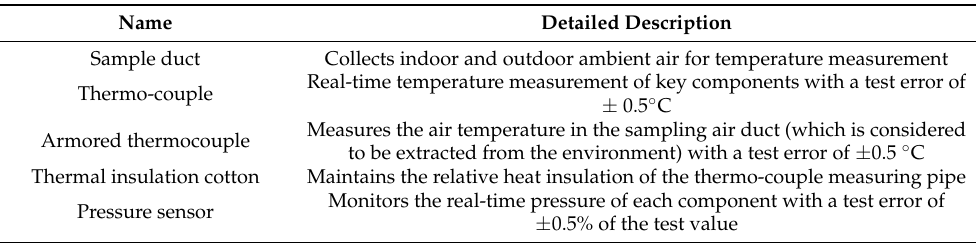
Table 2. Main measuring instruments and auxiliary experimental